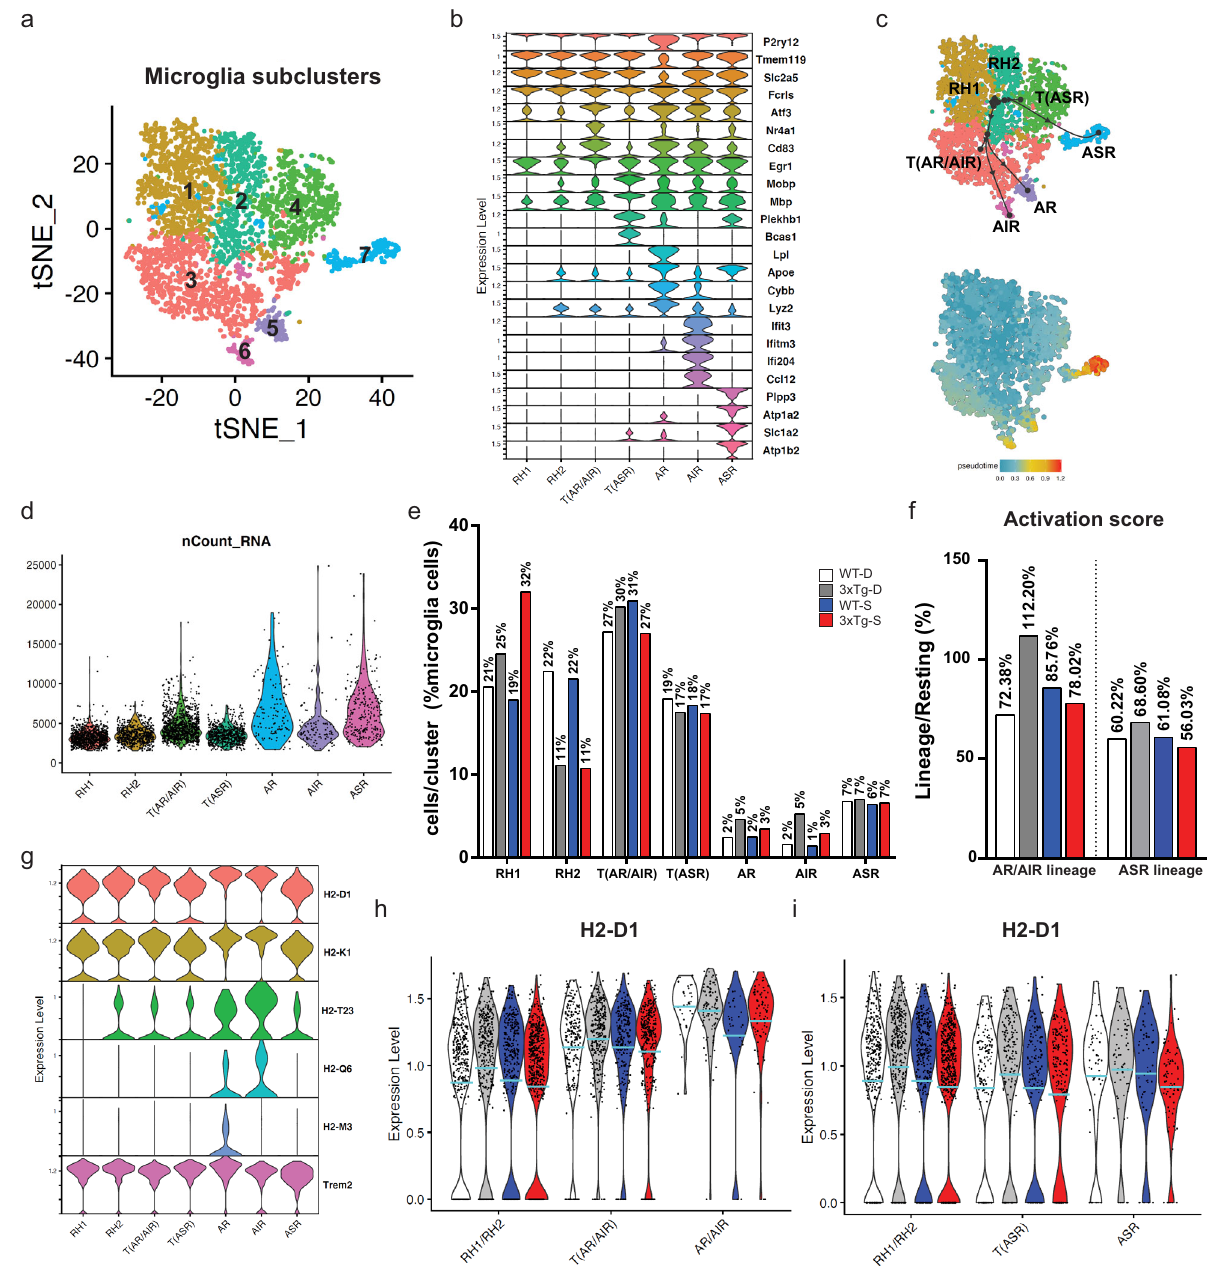
Fig. 6 Single-cell analysis uncovers SCDi-mediated changes to the cellular landscape of microglia. a tSNE plot showing the microglia population can be subclustered into seven microglial subtypes/activation states (subclusters 1 – 7). b Violin plots of top 4 DEGs used to de fi ne the microglia cluster (P2ry12, Tmem119, Slc2a5, Fcris) followed by the top 4 subcluster-speci fi c DEGs. Subclusters were annotated on the basis of prior single-cell RNA sequencing studies and additional strategies as described in the sections “ Results ” and “ Methods ” : Resting/Homeostatic (RH1, RH2, subclusters 1,2), Transitioning (T(AR/AIR), subcluster 3), Transitioning (T(ASR), subcluster 4), Active Response (AR, subcluster 5), Active Interferon Response (AIR, subcluster 6), Active Synapse-associated Response (ASR, subcluster 7). c PAGA-tree trajectory inference and pseudotime analysis of the microglia cluster, showing microglia subclusters annotated as “ Active ” (AR, AIR, ASR) have increased pseudotime transition. d Violin plot of nCounts across all microglia subclusters, showing the microglia subclusters annotated as “ Active ” (AR, AIR, ASR) have higher numbers of unique molecular identi fi ers (UMI) than “ Resting ” microglia (RH1, RH2). e Percentages of total microglia found in each subcluster in each experimental group. f Activation scores for the AR/AIR and ASR lineages for each experimental group. Activation scores were calculated as the lineage-positive cells ( “ Transitional ” + ” Active ” ) expressed as percentage of the resting cells (RH1 + RH2). 100% indicates an equal proportion of lineage-positive to resting cells. g Violin plots of showing relative expression of the top 6 SCDi-regulated genes (between 3xTg-D and 3xTg-S) across microglial subclusters. h , i Violin plots of expression levels of H2-D1 in the AR/AIR lineage ( h ) and ASR lineage ( i ) in each experimental group. Blue lines identify the average expression level. Legend of experimental groups in ( e ) applies to panels e , f , h , i . See Supplemental Figs. 6 – 8 and Supplemental Data Files 2,